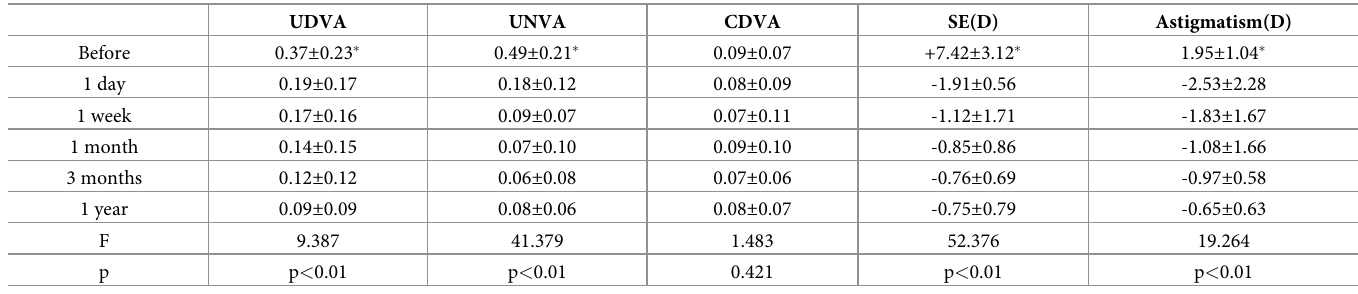
Table 1. Visual acuity and refraction before and after